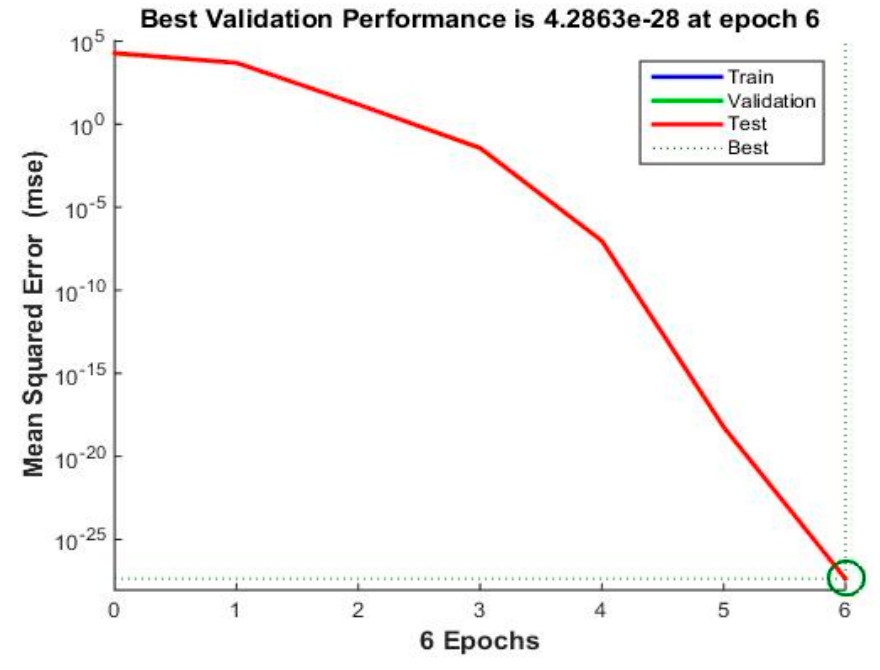
Figure 3. Performance of 50 layers.